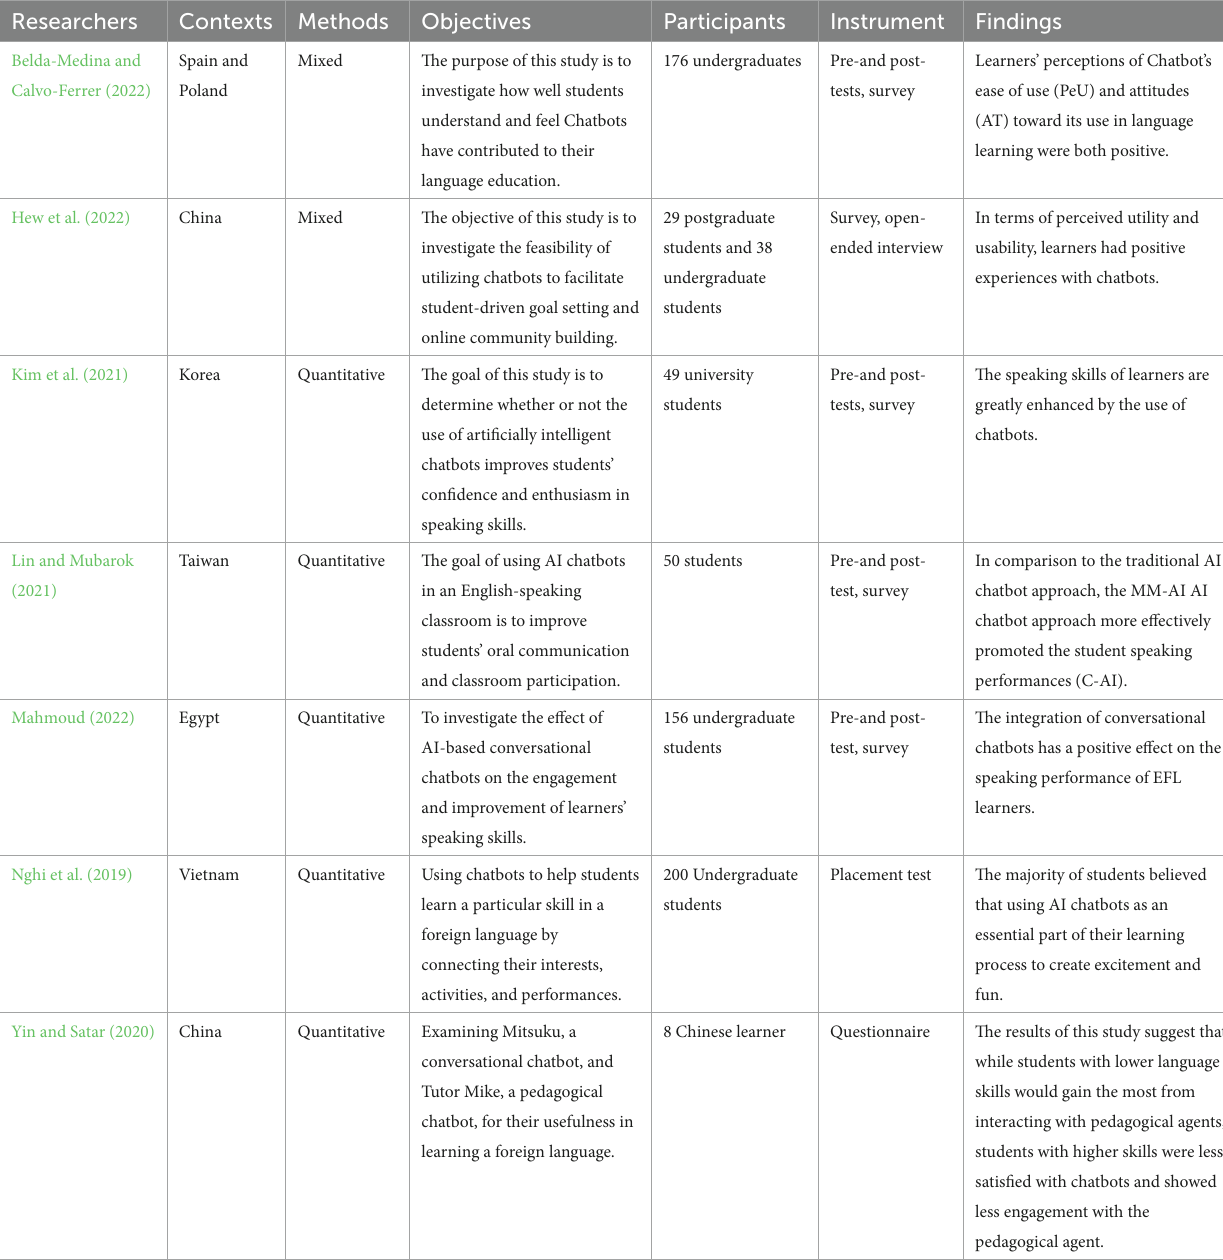
TABLE 1 Summary of publication trends of the existing empirical studies.